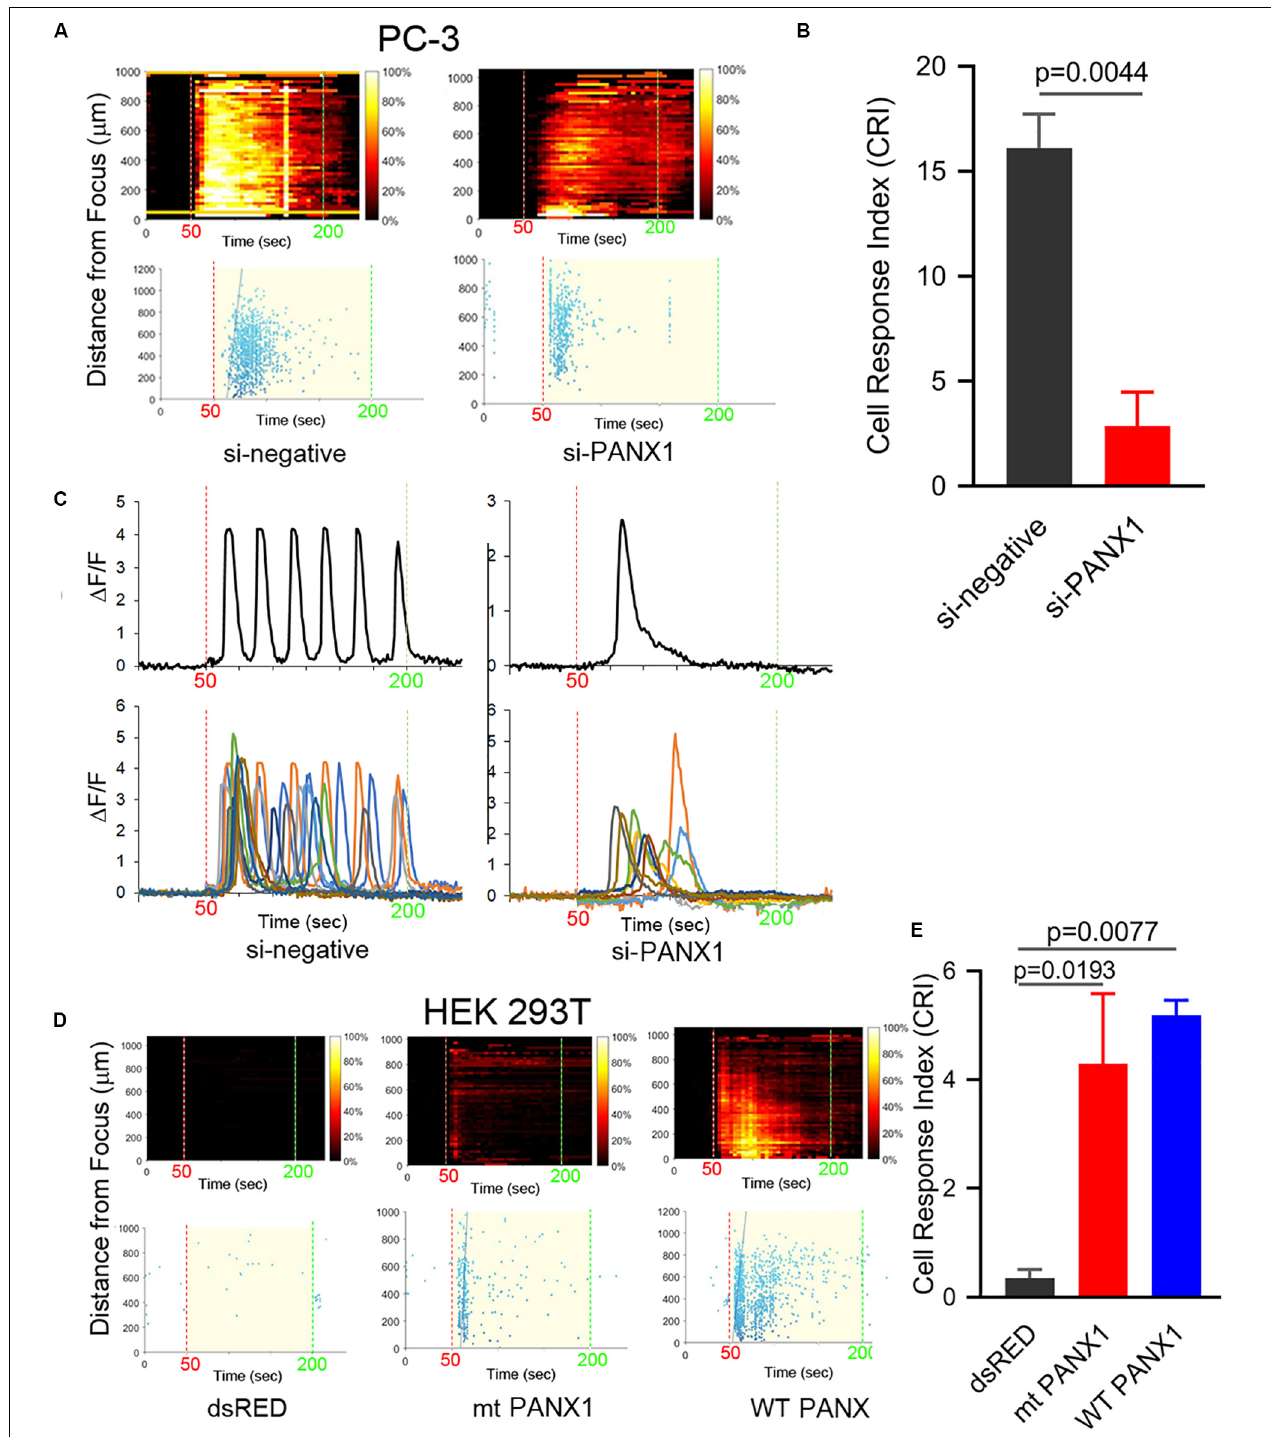
FIGURE 4 | PANX1 expression appears to be both necessary and sufficient for intracellular Ca 2 + responses. (A) si-PANX1 RNA treatment in PC3 cells reduced Ca 2 + responses compared to si-negative RNA (scramble) as a control. (B) Quantitative cell response index (CRI) values of the si-PANX1 RNA treatments relative to the control. n = 3. Error bars, s.e.m., exact p -values by a two-tailed t -test. (C) Fluorescence patterns in cells that first responded to the FUS stimulus after the treatments. One representative cell (top) is shown with fluorescence patterns in ten cells (bottom). (D) HEK293T cells transfected with WT PANX1 or mt PANX1 1 − 89 -mRFP (mt PANX1-mRFP) constructs showed Ca 2 + responses while control HEK cells transfected with dsRED construct have no FUS-induced Ca 2 + response. (E) Quantitative CRI values of the transfected cells. n = 3. Error bars, s.e.m., ANOVA, Dunnet’s correction, exact p values.